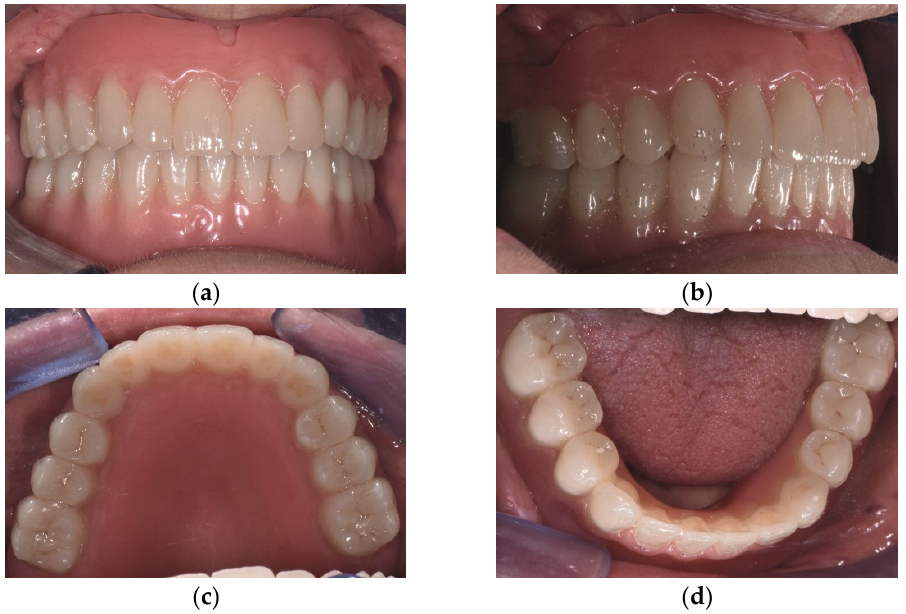
Figure 8. Intraoral view of definitive complete removable prostheses: ( a ) Frontal view; ( b ) right lateral view; ( c ) occlusal view of upper jaw; ( d ) occlusal view of lower jaw.